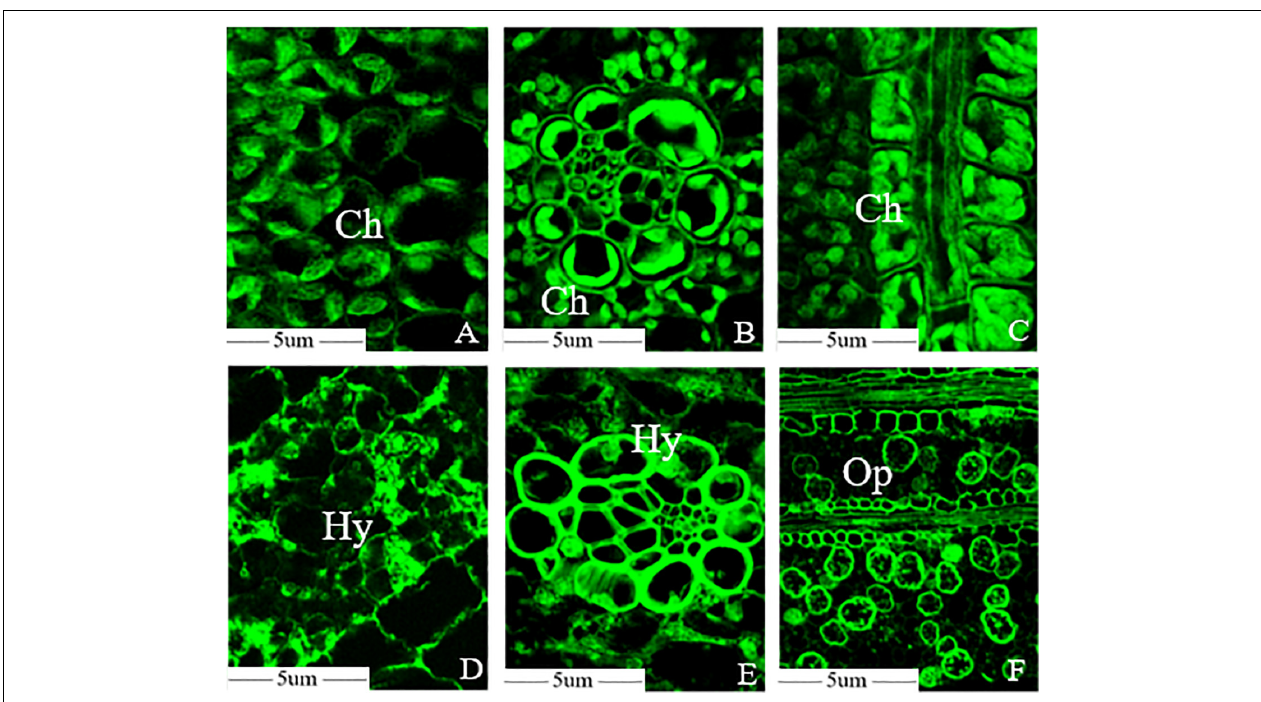
FIGURE 2 | Sclerospora graminicola destroyed the mesophyll cells of foxtail millet. (A) Mesophyll cell microstructure of foxtail millet leaves; (B) bundle sheath cells microstructure of foxtail millet leaves; (C) transverse sections microstructure of foxtail millet leave; (D) mesophyll cell microstructure of infected leaves; (E) bundle sheath cells microstructure of infected leaves; (F) transverse sections microstructure of infected leaves. Ch, chloroplast; Hy, mycelium; Op,